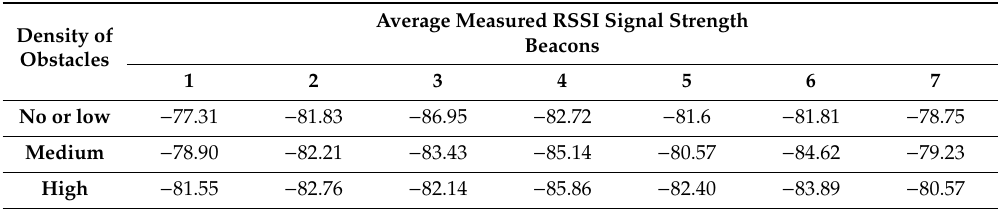
Table5. AveragemeasuredRSSIsignalstrength(measuredindB)inrelationtothedensityofphysicalobstacles. Density of